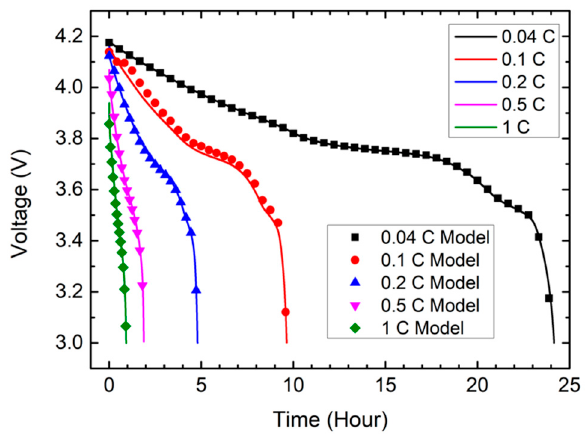
Figure 13. Curve of S brand 18650, Epoch = 100, look_back = 10.